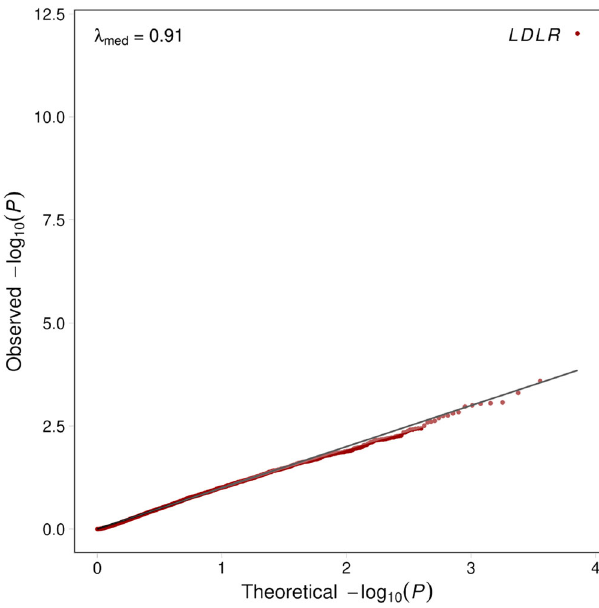
Fig. 5 Quantile-quantile plot for gene-based test statistics generated using TRAPD and RV-EXCALIBER for 3352 healthy control participants in MIGen. A total of 4160 genes with OAC ≥ 1 in MIGen and EAC ≥ 10 in gnomAD non-Finnish Europeans were used to conduct gene burden testing using rare, pathogenic alleles according to the TRAPD (red points) and RV- EXCALIBER (blue points) methods. To gauge calibration of test statistics between methods, 3352 healthy MIGen control participants were compared to gnomAD non-Finnish Europeans. The remaining subset of 2730 MIGen healthy controls were used as the gCF ranking cohort. The genomic in fl ation estimates were evaluated at the median ( λ med and 95th percentile ( λ 95 ) of test statistics. The solid black line indicates an expected uniform distribution of P -values under the null and the shaded region represents the 95% con fi dence interval of the expected uniform distribution of P -values. log 10 ( P ) refers to the log base 10 of a gene-based P - value. Source data are provided as a Source data fi le.